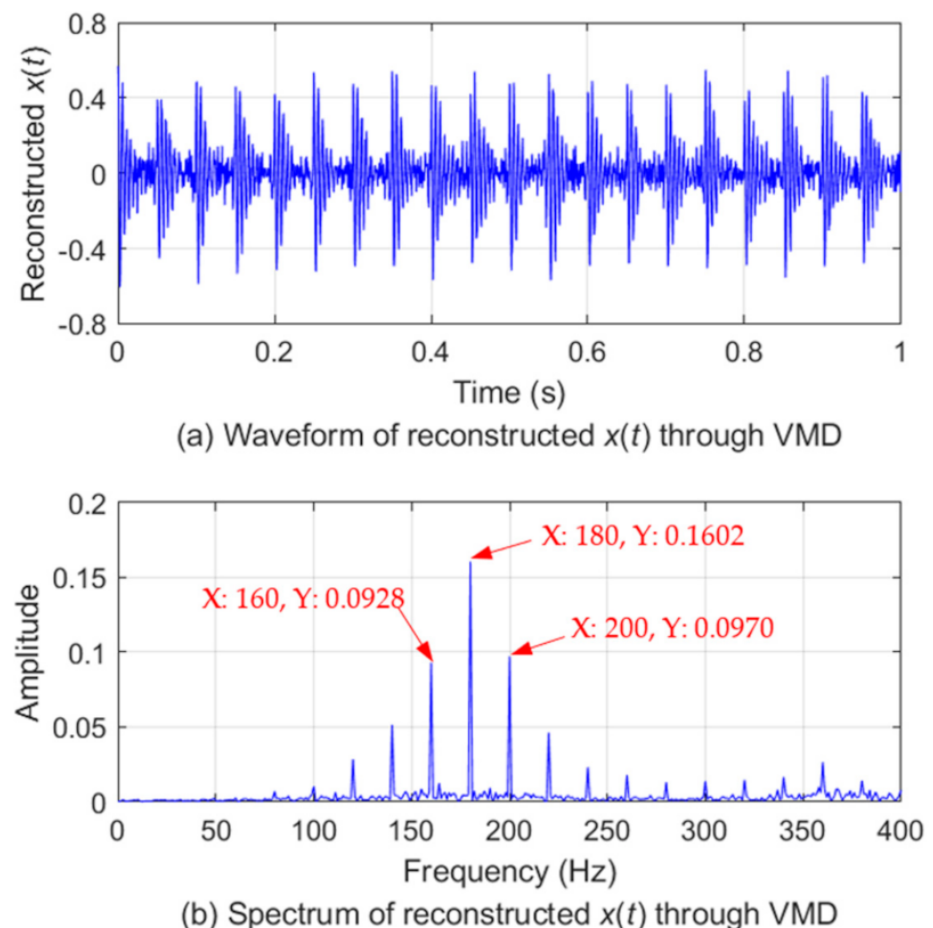
Figure 9. Reconstructed experimental signal and its spectrum through VMD.